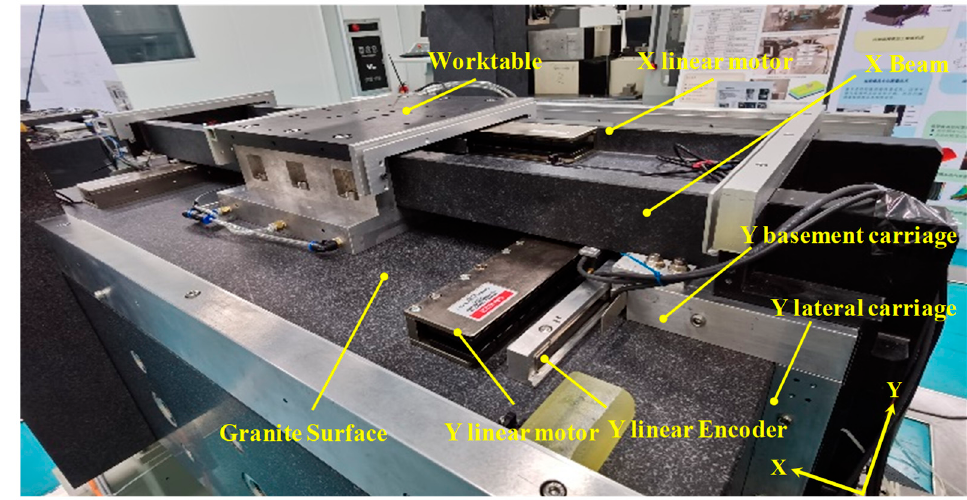
Figure 1. The basic arrangement of the X -axis and Y -axis of a three-axis machine tool.